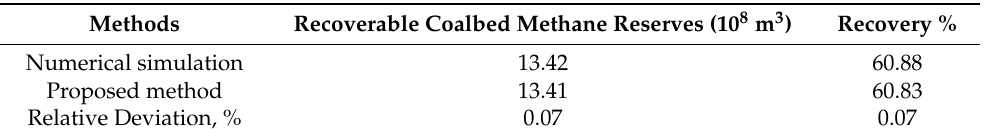
Table 2. Comparison of recoverable reserves and recovery predicted by the proposed method with numerical simulation